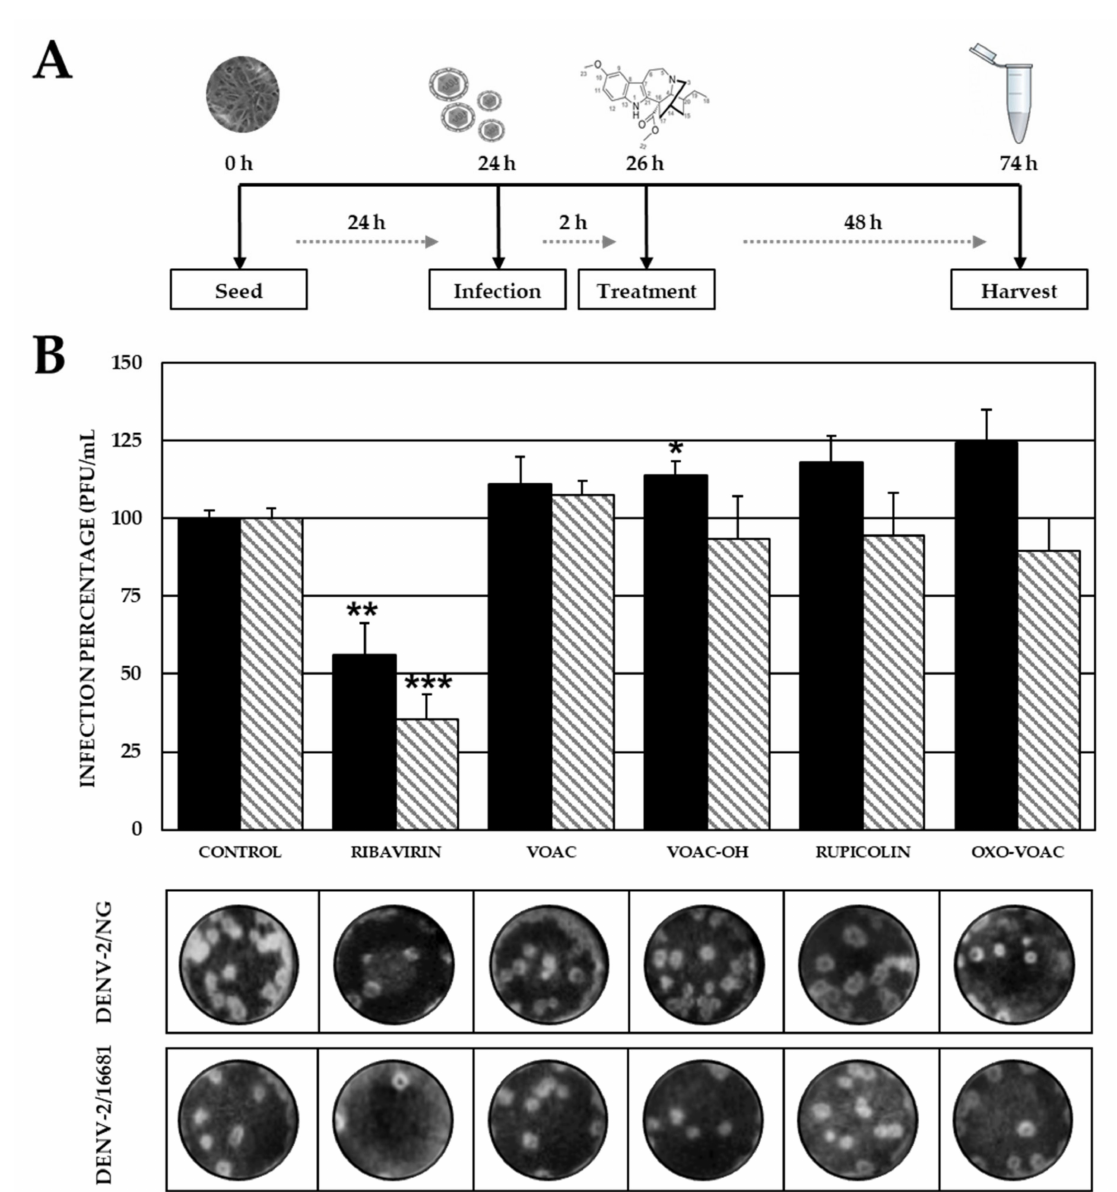
Figure 5. Antiviral effects on viral production (DENV-2) using the post-treatment strategy. ( A ) Schematic representation of the post-treatment strategy explained in the Materials and Methods section. ( B ) Infection percentage in each experimental condition. Vero cells were infected with DENV-2/NG (Dark bars) or DENV-2/16681 (Clear bars) and after that were treated. Infection percentage in each experimental condition. The asterisks indicate statistically significant differences with respect to the control without compound (* p < 0.05, ** p < 0.01 and *** p < 0.001; t -Student) and error bars indicate standard error of the mean; n : 4. Moreover, it shows representative images of plaque formed in each experimental